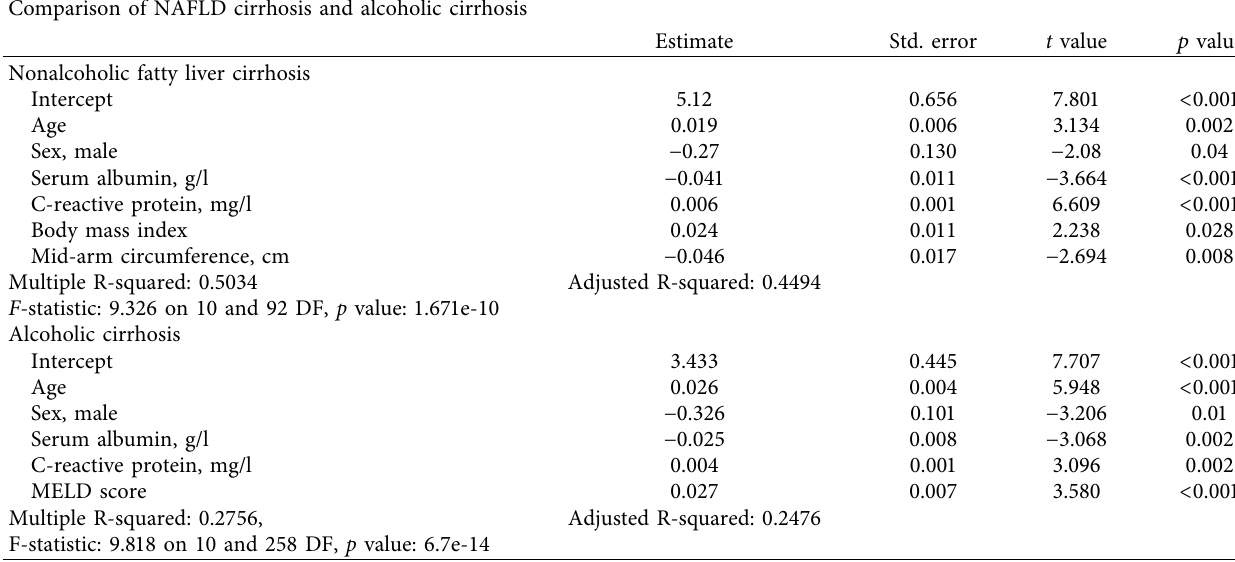
Table 4: Predictive factors of the liver frailty index in a linear